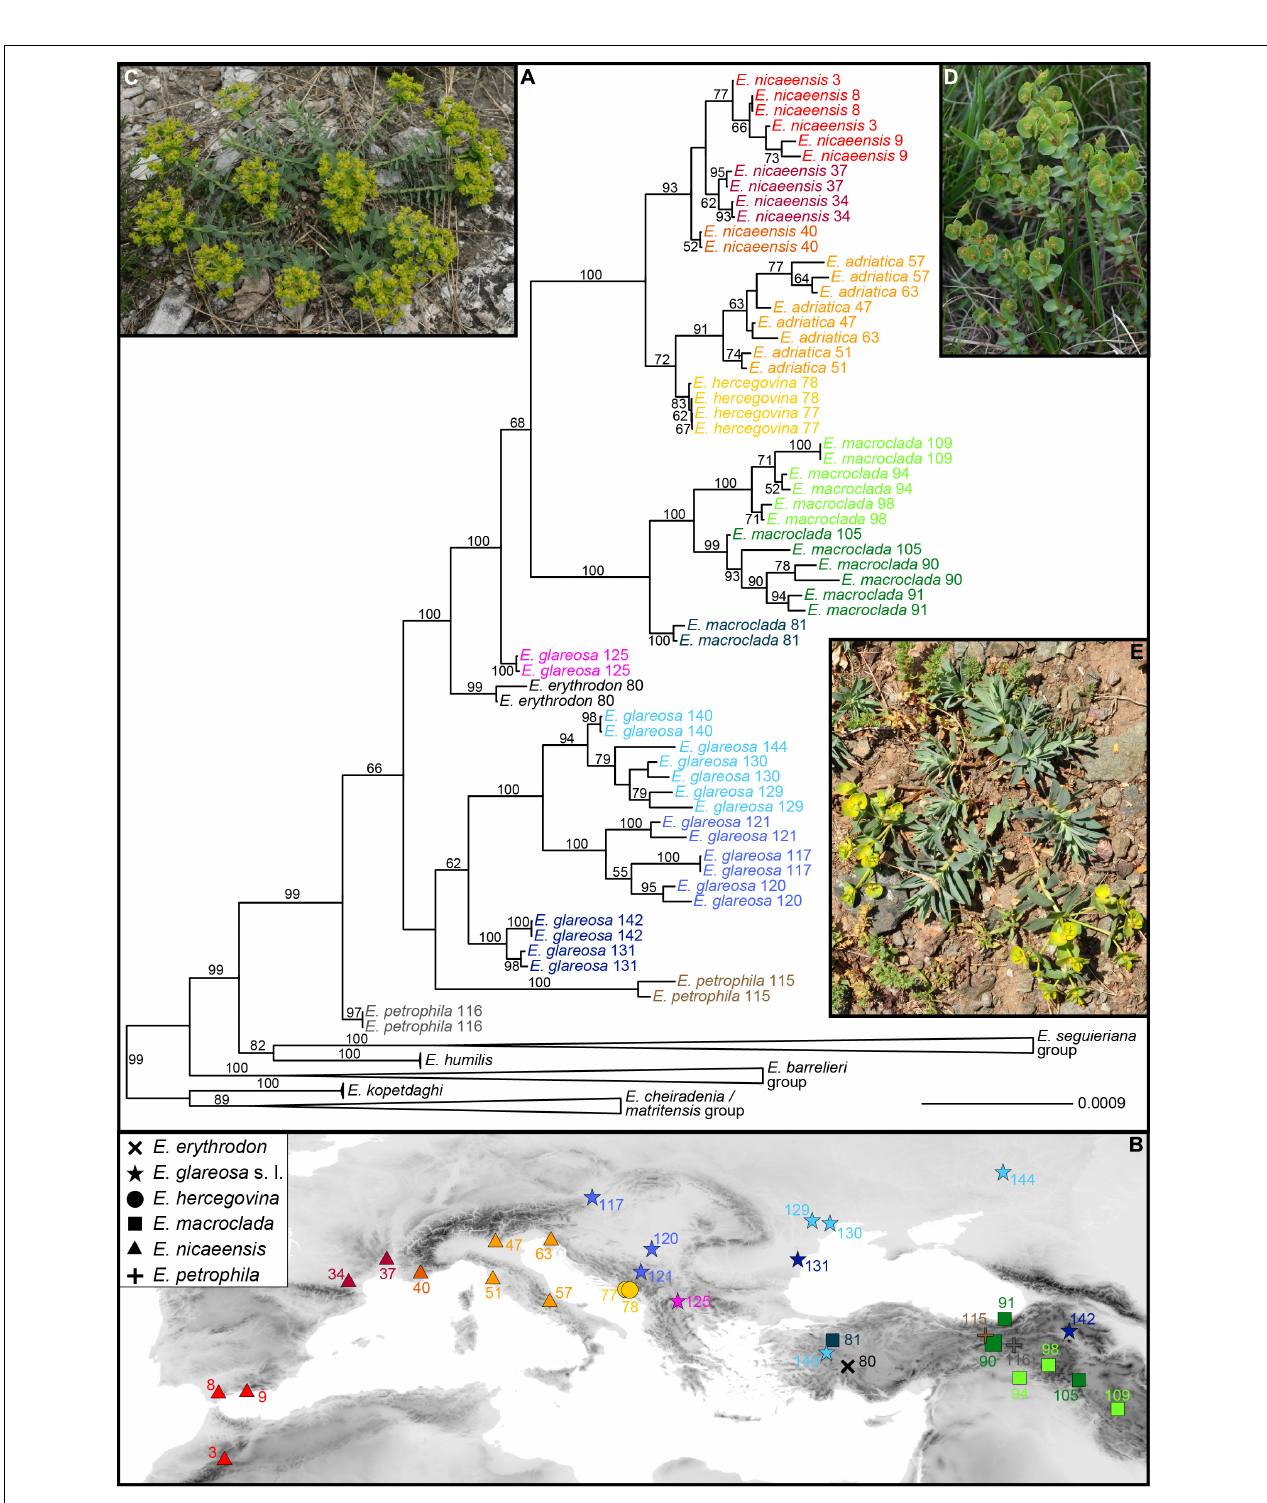
FIGURE 3 | (A) Phylogenetic relationships within the Euphorbia nicaeensis alliance and between this alliance and its closest relatives within E. sect. Pithyusa , as inferred by maximum likelihood analysis of RADseq loci, with indicated bootstrap values above 50%. (B) Geographic provenance of the investigated populations with colour coding as in (A) . Two outgroup species, E. seguieriana (from Austria; C ) and E. triflora (from Slovenia; D ) from the E. seguieriana and the E. barrelieri groups, and the ingroup E. petrophila (from Turkey; E ) are shown in situ . Photos: B. Frajman (C,D) , C. Gilly (E) . Population numbers correspond to Supplementary Table 1 . The tree, including outgroup taxa, is presented in Supplementary Figure 2